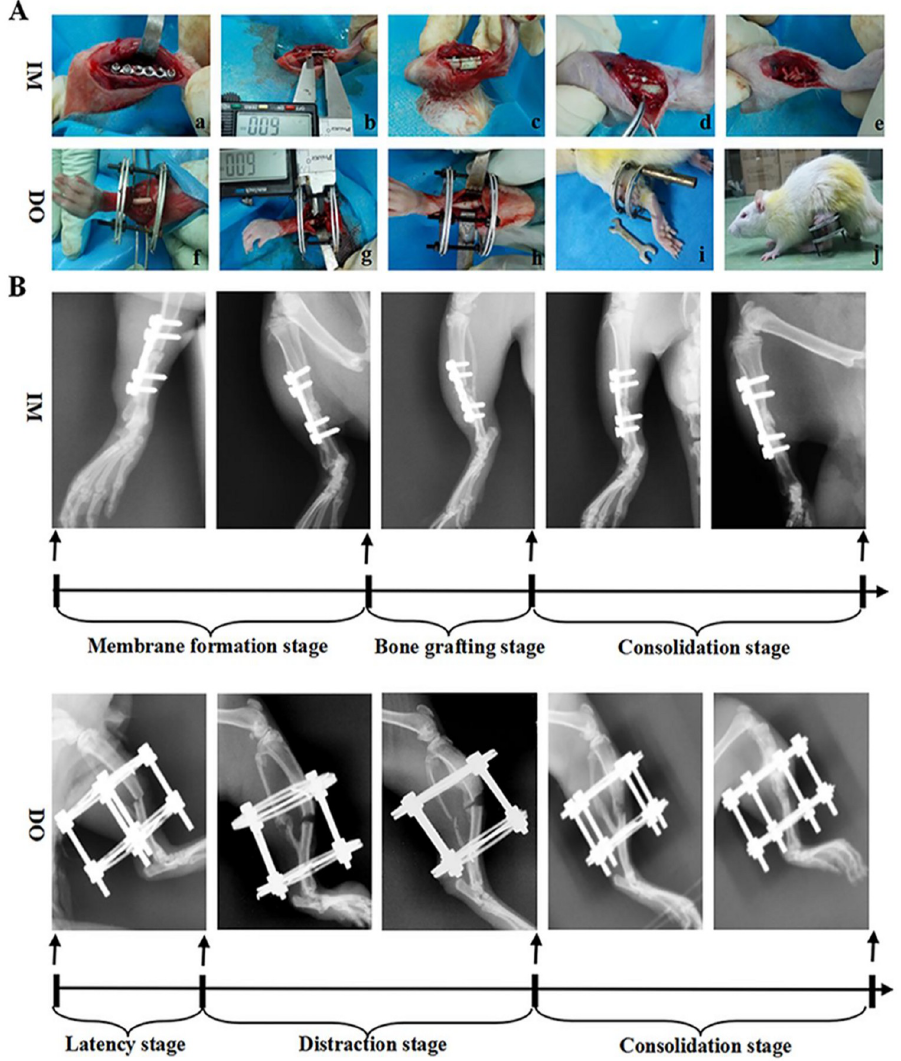
Fig 1. Animal models of SBD in rats. (A) Flowcharts of surgical procedures of SBD models by the internal plate and external fixator. (a): tibia exposure and plate fixation; (b): osteotomy; (c): bone cement implantation; (d): induced membrane formation; (e): bone grafting; (f): tibia exposure and external fixator fixation; (g): osteotomy; (h): shortening and aligning osteotomy ends; (i): distraction procedure; (j): consolidation stage. (B) Protocols of IM and DO shown by